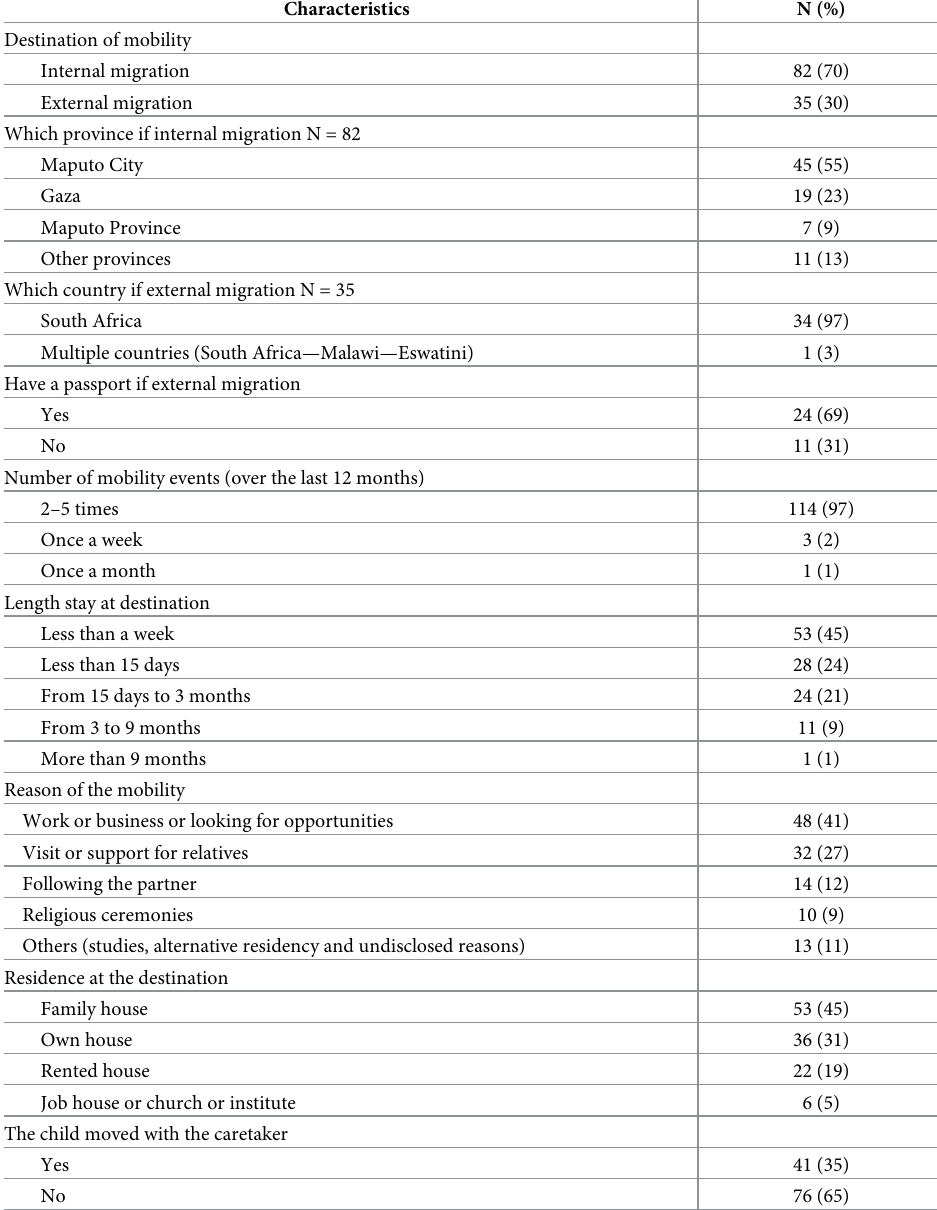
Table 2. Migration patterns of HIV children’s caregivers enrolled in care at Manhic¸a District Hospital.